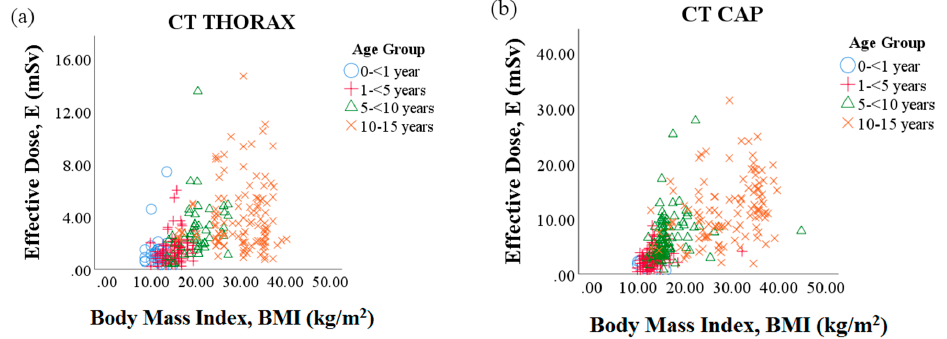
Figure 1. The positive correlation between effective dose (E) and body mass index in paediatric CT examination in each age category. ( a ) CT thorax (r = 0.47) ( b ) CT CAP (r = 0.65).